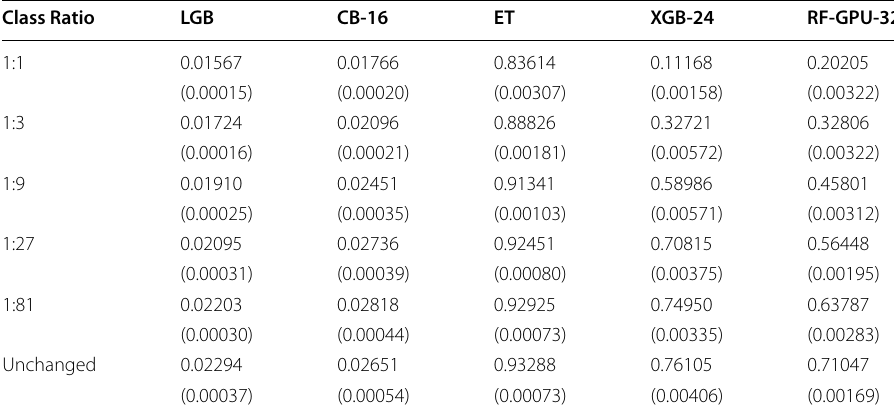
Table 10 Part-D mean and standard deviation of AUPRC with varying levels of RUS (10 iterations of fivefold